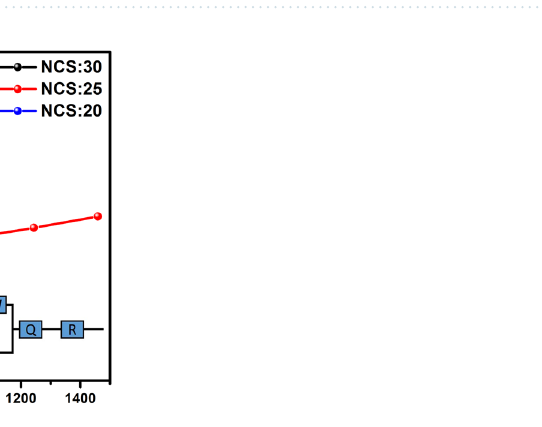
Table 1. NiCo 2 S 4 based electrodes and their electrochemical performance.